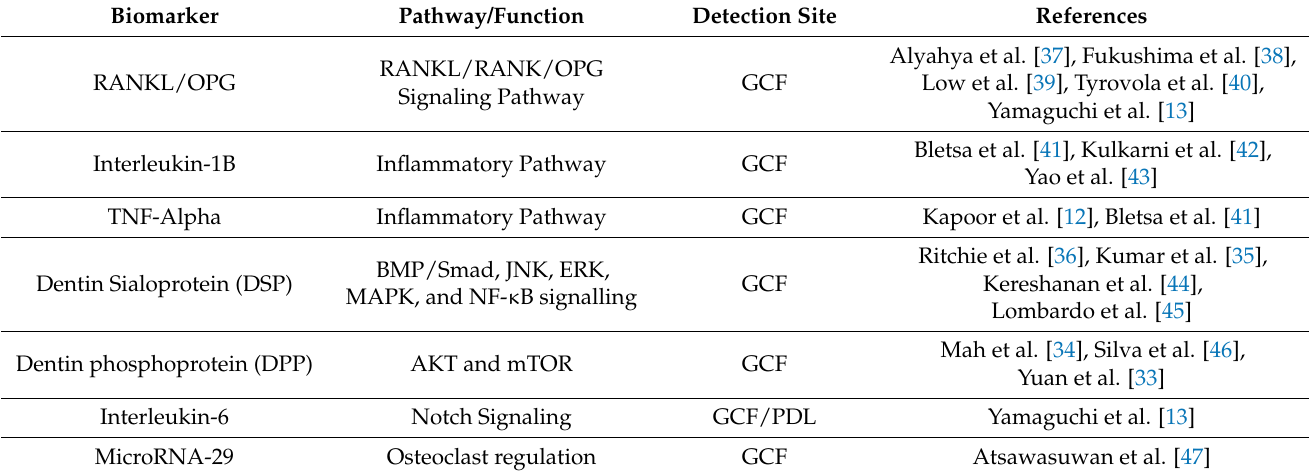
Table 1. Multiple GCF (gingival crevicular fluid) biomarkers are involved in ERR (external root resorption). This table presents their names, pathways, and site of